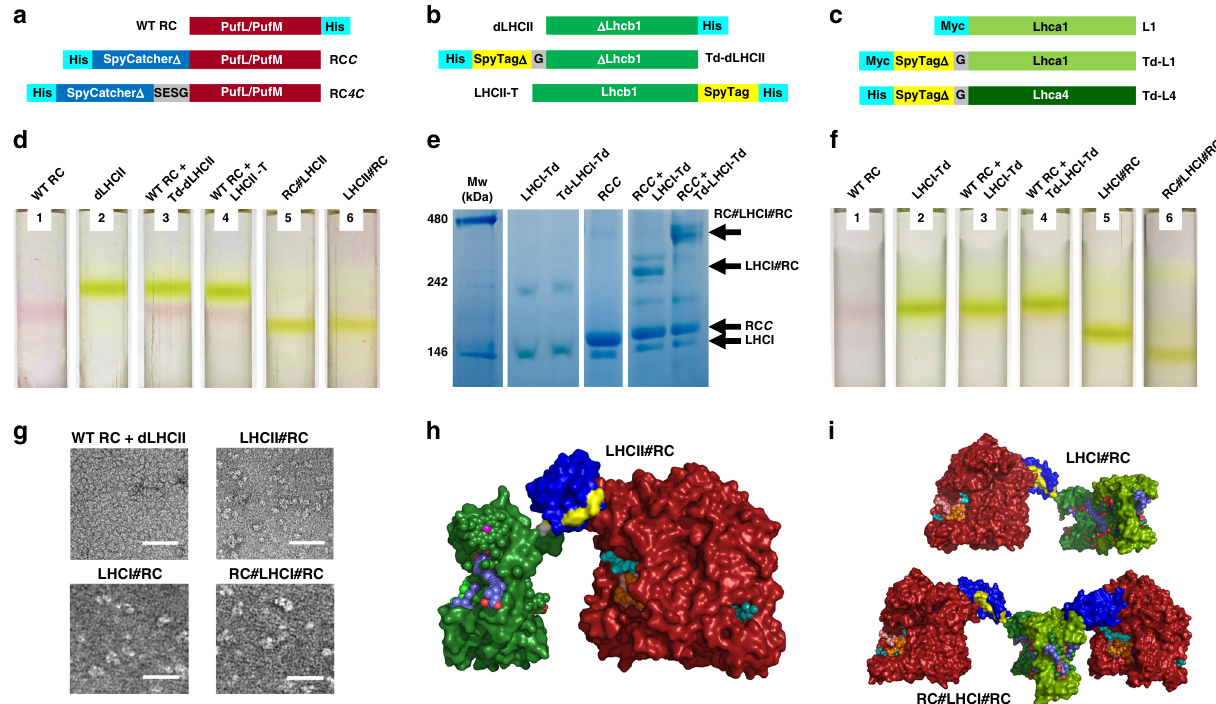
Fig. 3 Engineering and assembly of RC-LHC chimeras. a Construct designs for adaptation of the RC. For puri fi cation the WT RC was modi fi ed with a His- tag on PufM. b Construct designs for adaptation of LHCII. The control LHCII was truncated at its N-terminus (dLHCII — see text) and was His-tagged at its C-terminus. c Construct designs for adaptation of LHCI which is an Lhca1/Lhca4 heterodimer. For b and c protein sequences are given in Supplementary Fig. 5a. d Sucrose density gradient fractionation of RCs (red bands) and LHCIIs (green bands). RC-LHCII chimeras migrate to a lower position in gradients than either RC or LHCII monomers, with no dissociation into components. e Blue NativePAGE showing the formation of high molecular weight products by mixing LHCI-Td or Td-LHCI-Td with RC C (see Supplementary Fig. 7a for the full gel with more combinations). The multiple bands seen for the high molecular weight products are likely to be due to conformational heterogeneity. f Sucrose density gradient fractionation of RCs (red bands) and LHCIs (green bands). LHCI#RC chimeras and larger RC#LHCI#RC chimeras migrate to lower positions than either RCs or LHCI. g TEM images of an equimolar mixture of the WT RC and dLHCII (top/left), the LHCII#RC chimera (top/right), the LHCI#RC chimera (bottom/left) and the RC#LHCI#RC chimera (bottom/right). Additional images shown in Supplementary Fig. 17. Scale bar represents 50 nm. h Molecular model of the LHCII#RC chimera. The RC (maroon) N-terminally adapted with SpyCatcher Δ (blue) is covalently linked to LHCII (green) C-terminally adapted with SpyTag (yellow). Cofactor colours are as described in Supplementary Fig. 1. i Molecular models of the LHCI#RC and RC#LHCI#RC chimeras. Colours as for panel h and Supplementary Fig. diameter (Fig. 3g, top/left), whereas images of the puri fi ed LHCII#RC chimera revealed two-domain objects (Fig. 3g, top/ right). The puri fi ed LHCI#RC and RC#LHCI#RC chimeras